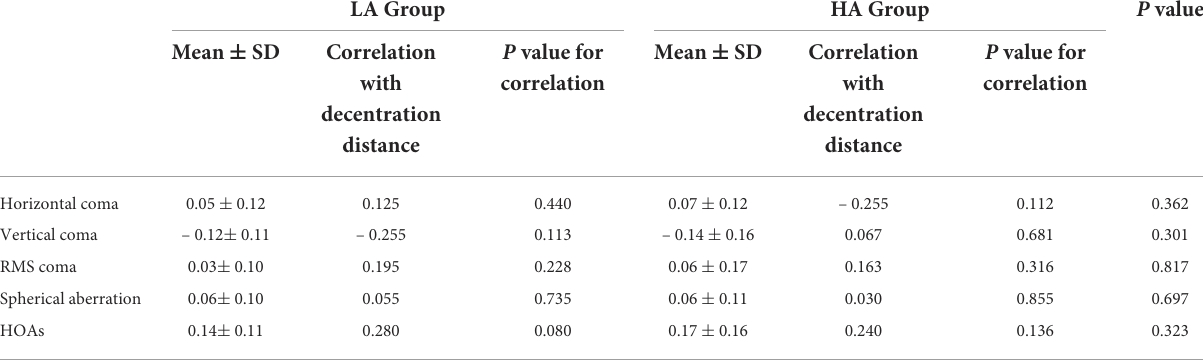
TABLE 3 Changes in corneal aberrations at 6 months after SMILE.